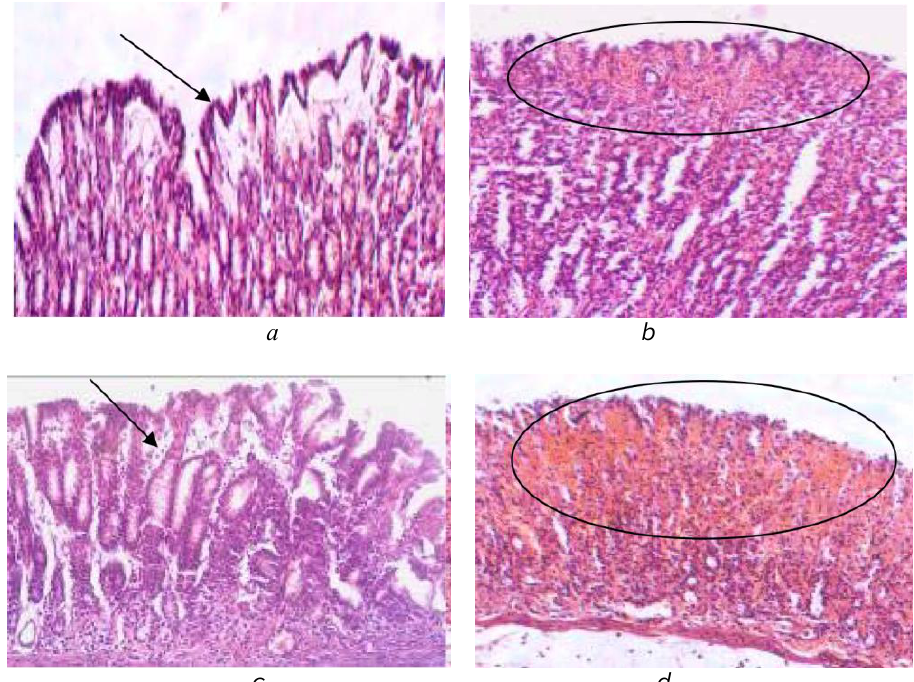
Fig. 7. The stomach of the rats, which were injected alcohol-prednisolone mixture. Stromal edema and pronounced full- blooded of the capillary network stasis of erythrocytes, bleeding in: a, b – fundal; c, d – pyloric parts. Hematoxylin- eosin.